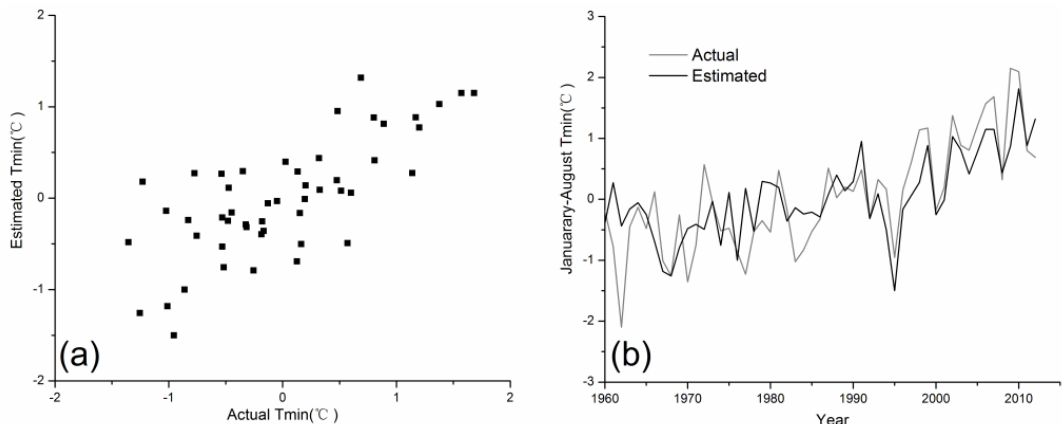
Figure 6. Scatter plot (a) and time series (b) of the actual and estimated T min anomalies during the calibration period from 1960 to 2011. Fig. 6 Scatter plot (a) and time series (b) of the actual and estimated Tmin anomalies during the 4 calibration period from 1960 to 2011. 5 4